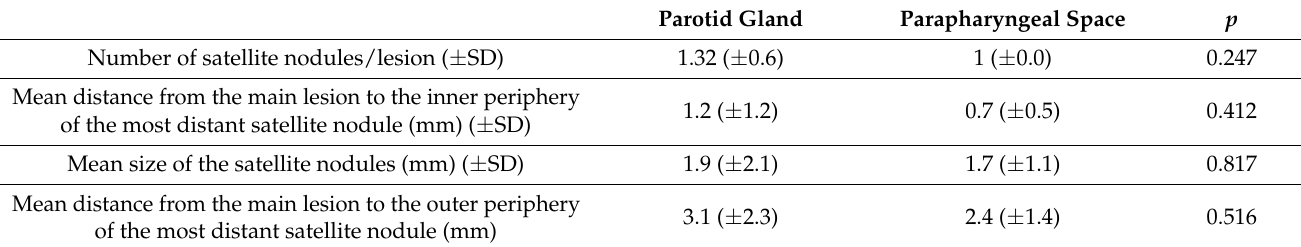
Table 3. Comparative analysis of the satellite nodule-specific histopathologic parameters in pleomor- phic adenomas of the parotid gland and the parapharyngeal space in our